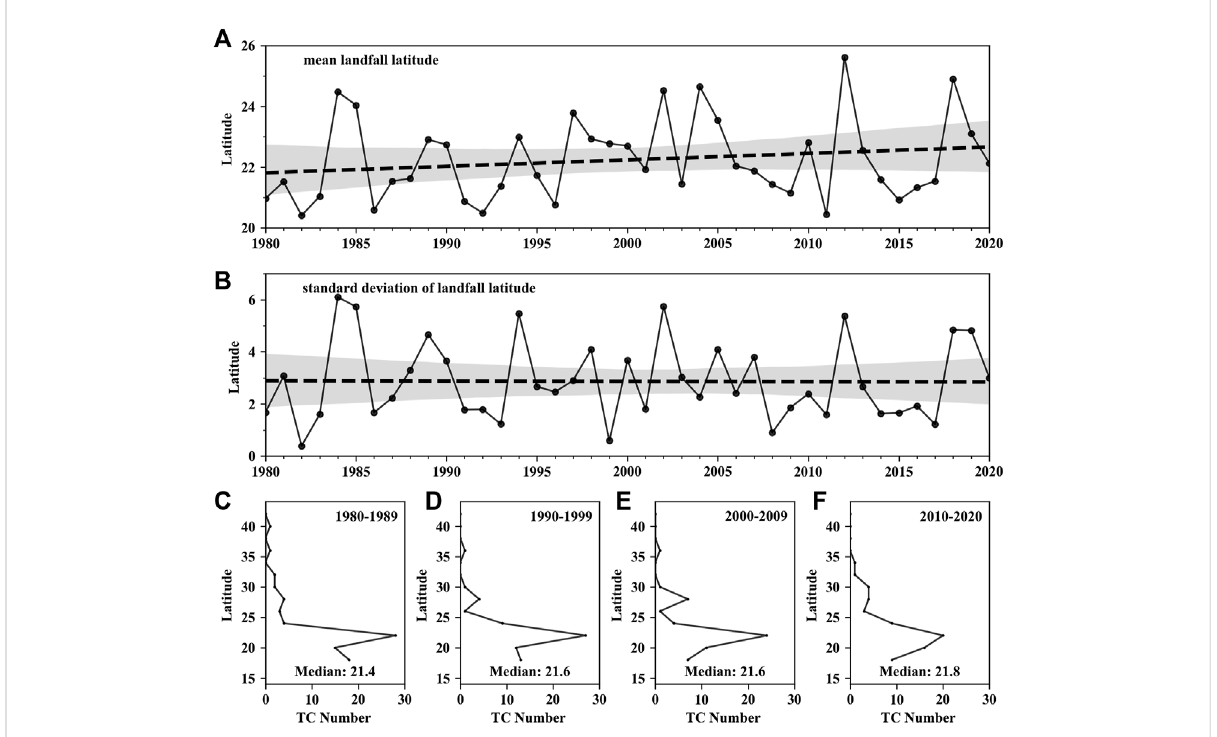
FIGURE 3 Thetimeseries andthelinear regression fi tsfor (A) theannualmeanofTCs ’ landfallinglatitudesand (B) thestandarddeviationoftheyearlyTCs ’ landfalling latitudes over mainland China from 1980 to 2020. The latitudinal distribution of TCs landfalling over mainland China for the periods: (C) 1980 – 1989, (D) 1990 – 1999, (E) 2000 – 2009, and (F) 2010 – 2020. The medians of the decadal TCs ’ landfall latitudes are also shown in the corresponding fi gures.